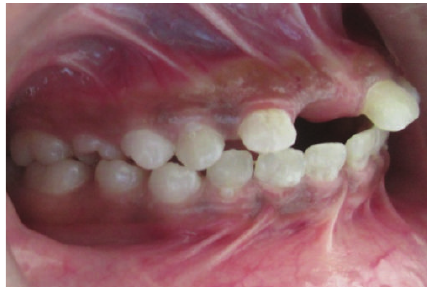
Figure 6: Intraoral photographs.